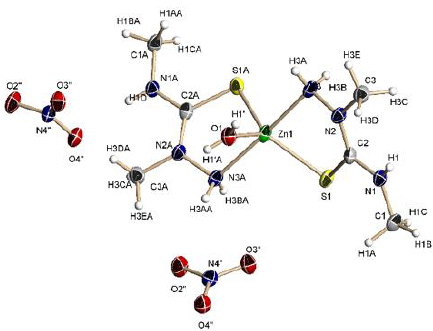
Figure 4. Molecular structure of 3. Thermal ellipsoids at 50% probability level.